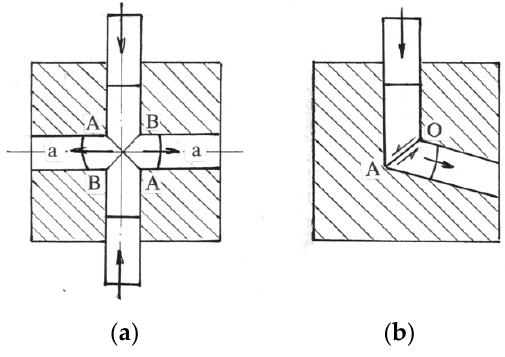
Figure 1. “Cross-extrusion” ( a ) and ECAE ( b ).